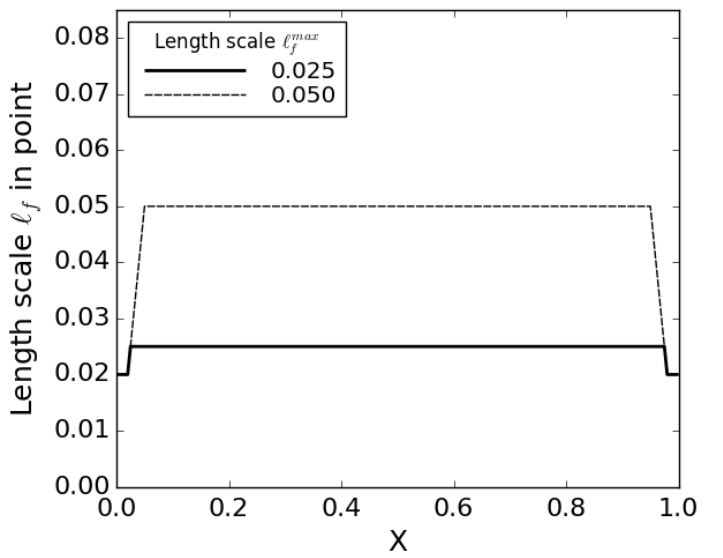
Figure 2. Limit spatial length scale distributions through 1D sFCM body ( L = 1) for two anal- ysed